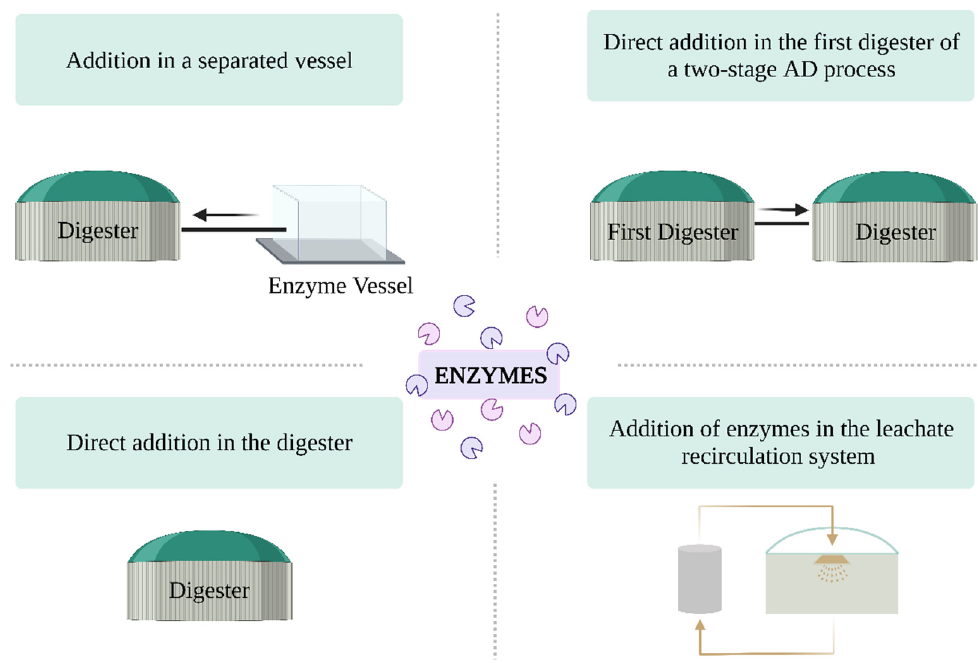
Figure 9. Different ways to perform enzyme addition to enhance AD performance.